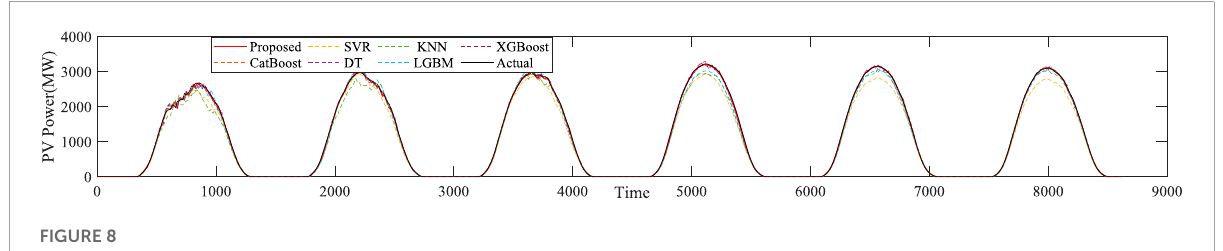
FIGURE 8 15-minutes-ahead forecasting results in summer.